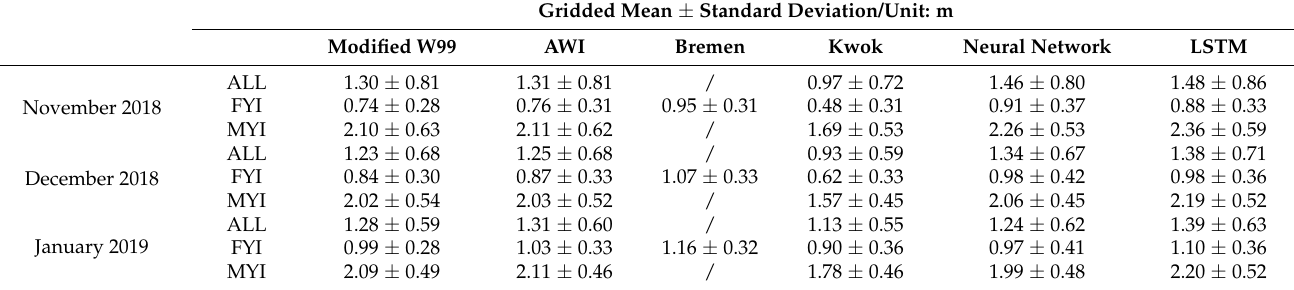
Figure 11. Spatial distribution of SIT from different snow depth product retrievals: ( a ) modified W99 snow depth, ( b ) AWI snow depth, ( c ) Bremen snow depth, ( d ) Kwok snow depth, ( e ) Neural Network snow depth and ( f ) LSTM snow depth. The dates from the first row to the last row are November 2018, December 2018, January 2019, February 2019, March 2019 and April 2019. Table 3. Statistical table of the seasonal variations in different Arctic SIT products over the common area of all data